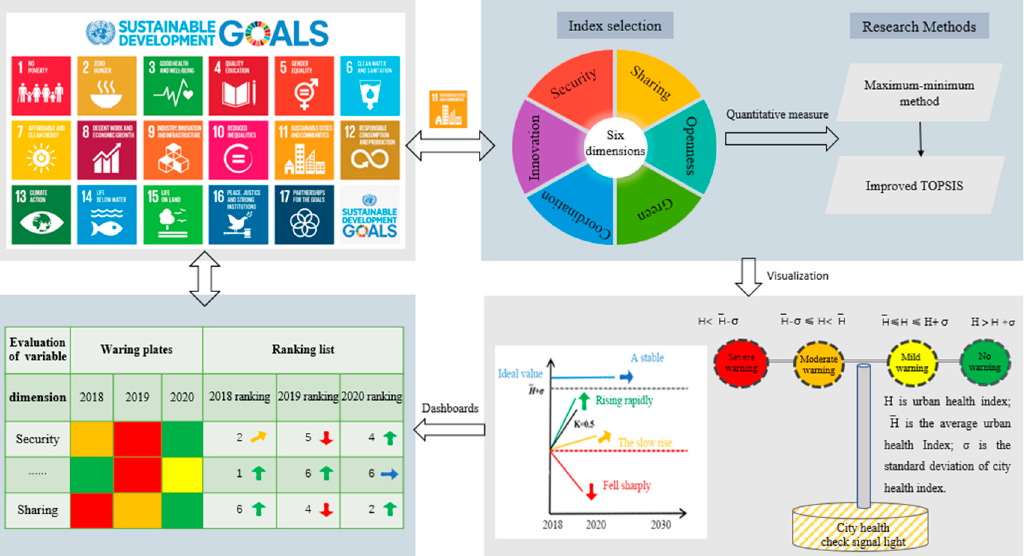
Figure 2. The construction process diagram of the city health examination signal light and warning panel in territorial spatial planning. (draw by authors).